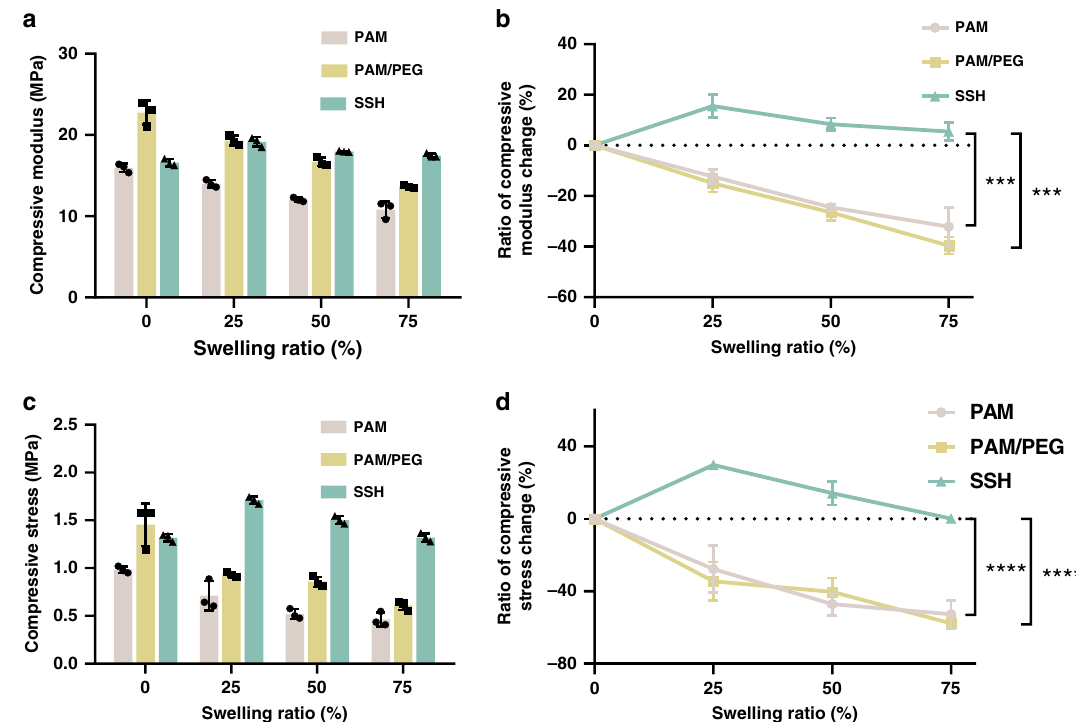
Fig. 2 Swelling-strengthening behavior of swelling-strengthening hydrogels (SSHs) in vitro. a Compressive modulus and b variation of compressive modulus versus swelling ratio. c Compressive stress and d variation of compressive stress at 90% strain versus swelling ratio. The strain rate was 5 mm/ min, and the dimension of the cylindrical samples was 5 × 3 mm. All error bars represent the mean ± SD ( n = 3 independent experiments). Signi fi cance was assessed using one-way ANOVA with Tukey ’ s multiple comparisons test, giving P values, *** P < 0.001, **** P <